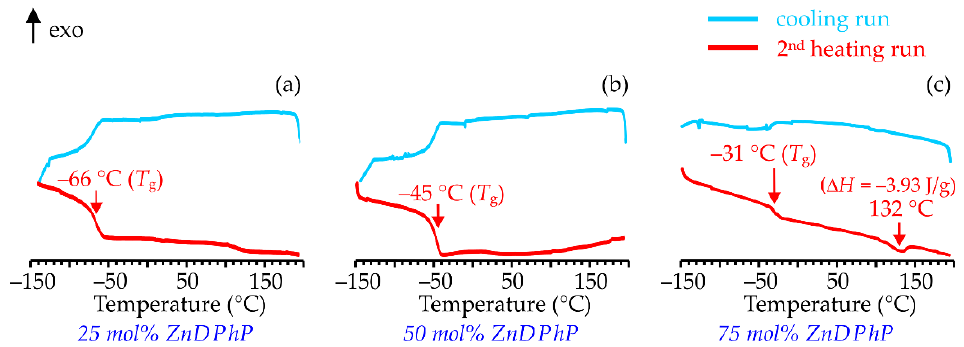
Figure 6. DSC traces of the ZnDBP- co -ZnDPhP copolymers containing different amounts of aromatic monomeric units: ( a ) 25 mol%, ( b ) 50 mol%, and ( c ) 75 mol%. The cooling and 2nd heating runs are presented.